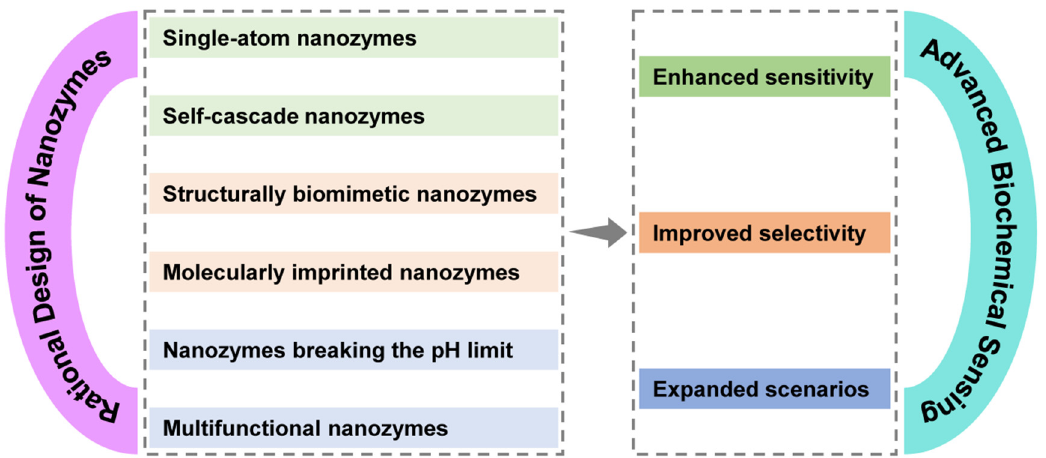
Figure 1. Diagram for the rational design of nanozymes, enabling advanced biochemical